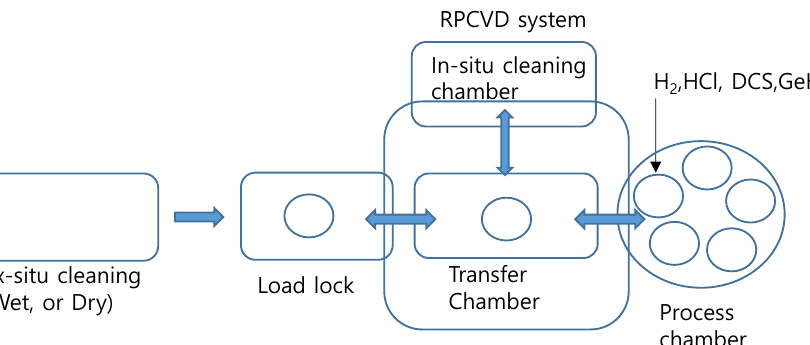
Figure 1. Basic schematic of epitaxial process flow using a reduced pressure chemical vapor deposi- tion (RPCVD) tool.